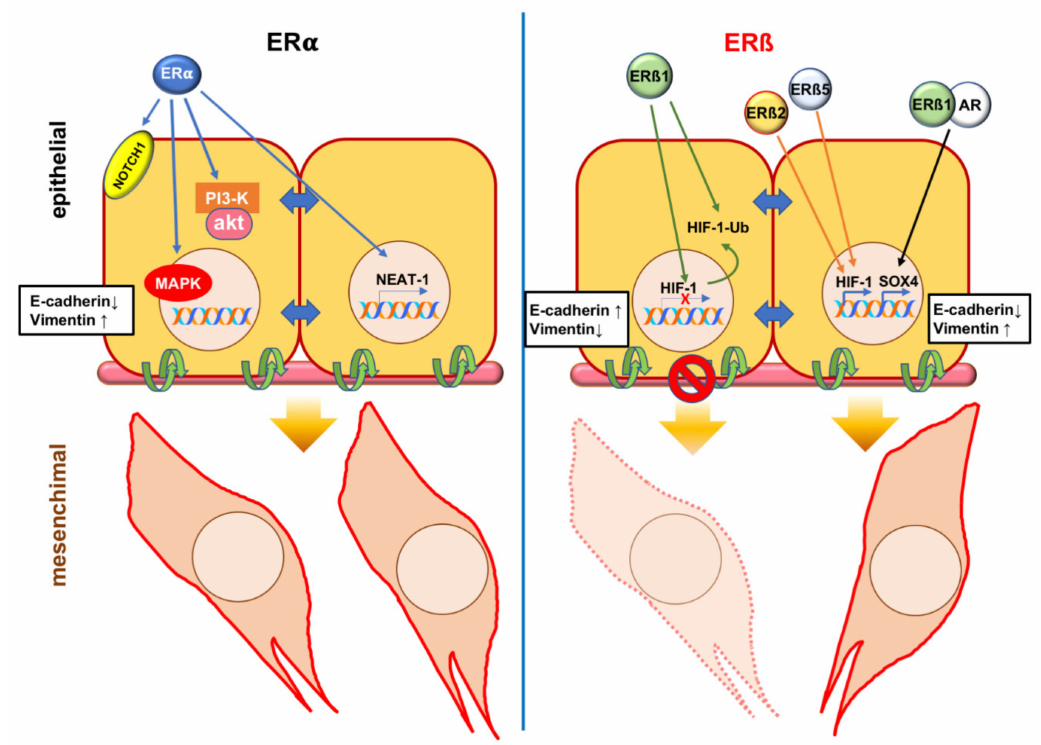
Figure 2. Estrogen receptor (ER) α or β control the epithelial mesenchymal transition (EMT) program in prostate cancer (PC). Left panel : the ligand activated ER α might induce EMT through transcriptional up-regulation of Neurogenic locus notch homolog protein 1 (NOTCH1) [71] or nuclear enriched abundant transcript 1 (NEAT-1) [70]. Phosphoinositide 3-kinase (PI3-K) / AKT and Ras / Mitogen activated protein kinase (MAPK) pathways both induce EMT of PC [25,26]. As the ligand-bound ER α triggers activation of both these pathways in target cells [27–29], it might be argued that such activation leads to EMT in PC. Right panel : the ligand activated ER β 1 hinders EMT by repressing the transcription of hypoxia-induced factor 1 α (HIF-1 α ) and promoting its degradation by proteasome [93]. By stabilizing HIF-1 α , ER β 2 and 5 promote EMT [46]. Under certain conditions, ER β 1 could dimerize with androgen receptor (AR) upon being challenged with estrogens. Sex determining region Y box 4 (SOX4) up-regulation follows and this event leads to EMT in PC